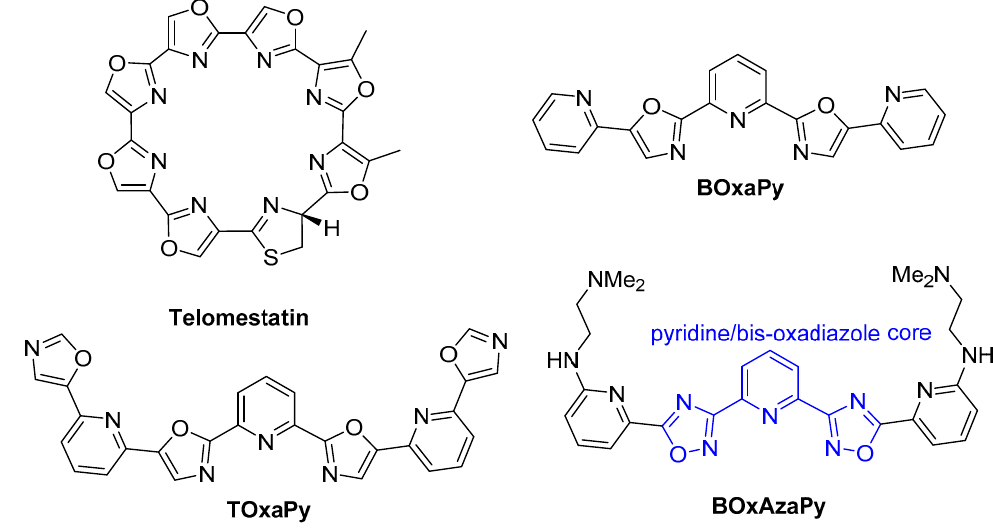
Figure 1. Structure of Telomestain, together with non-macrocyclic and flexible oligoaromatics previously evaluated as G4 ligands [21,22].